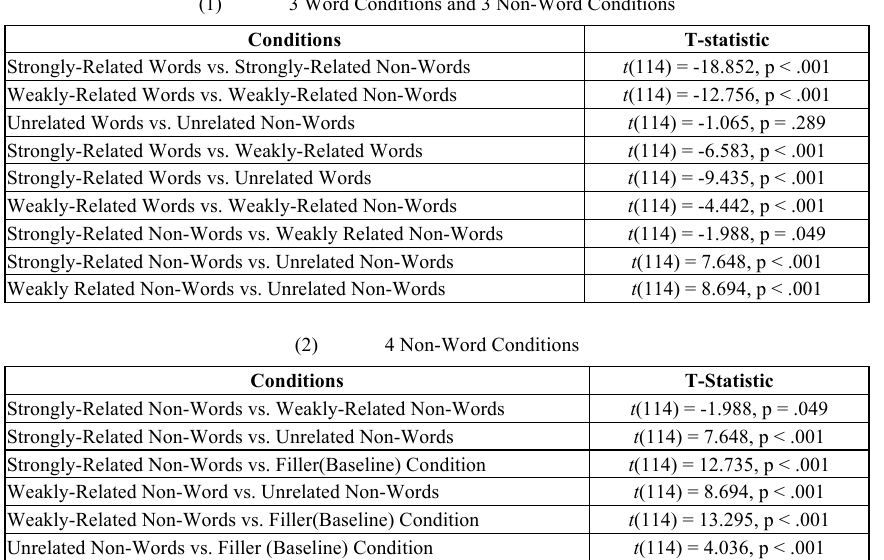
Table 4. Paired-Samples T-Test for Experiment 1 (1)